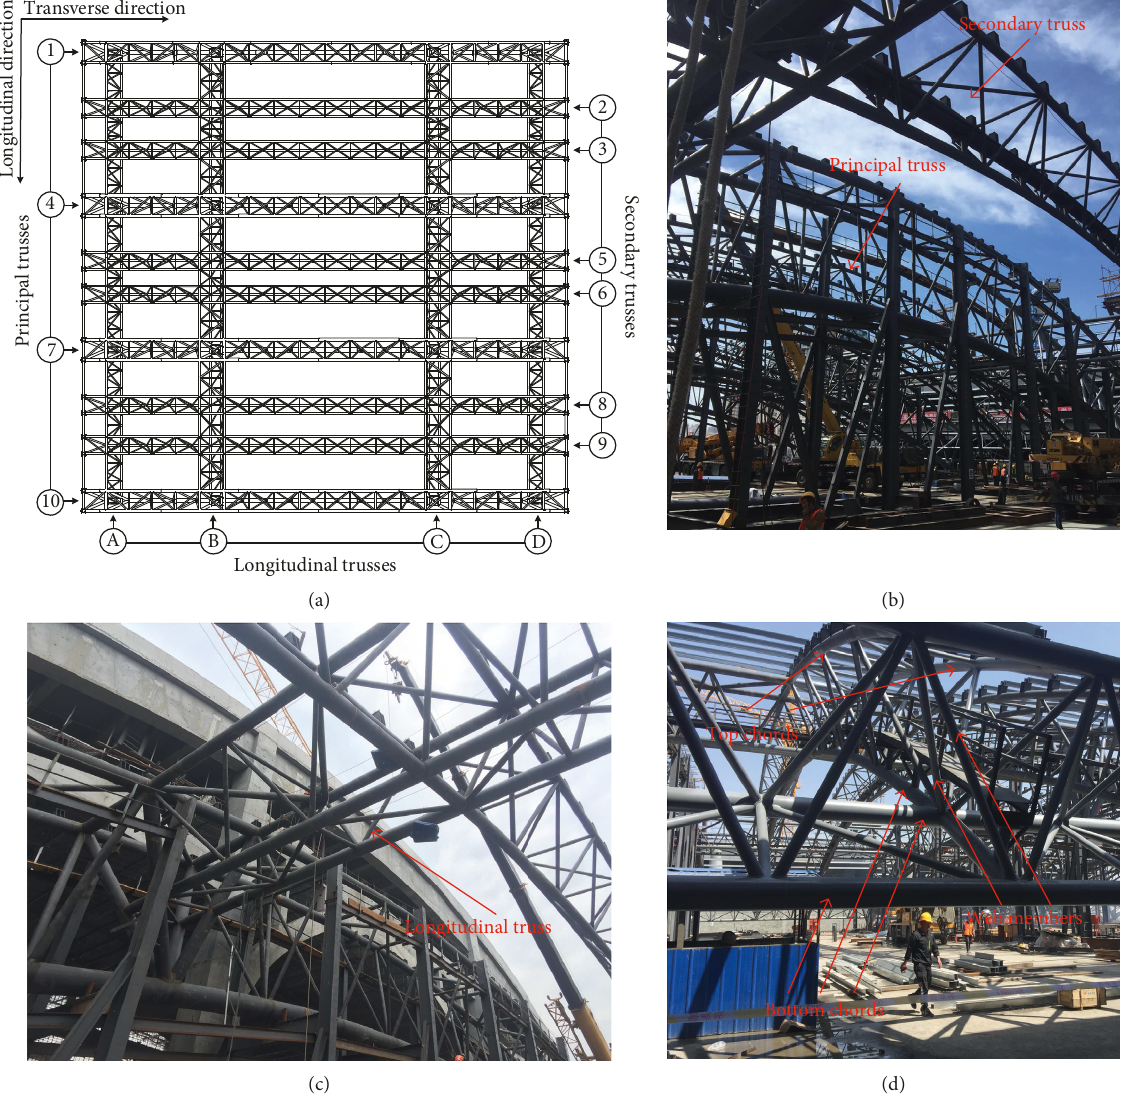
Figure 9: The completed first phase of the steel structure roof: (a) the arrangement of transverse trusses and longitudinal trusses; (b) the transverse trusses; (c) the longitudinal truss; and (d) the top chords, bottom chords, and web